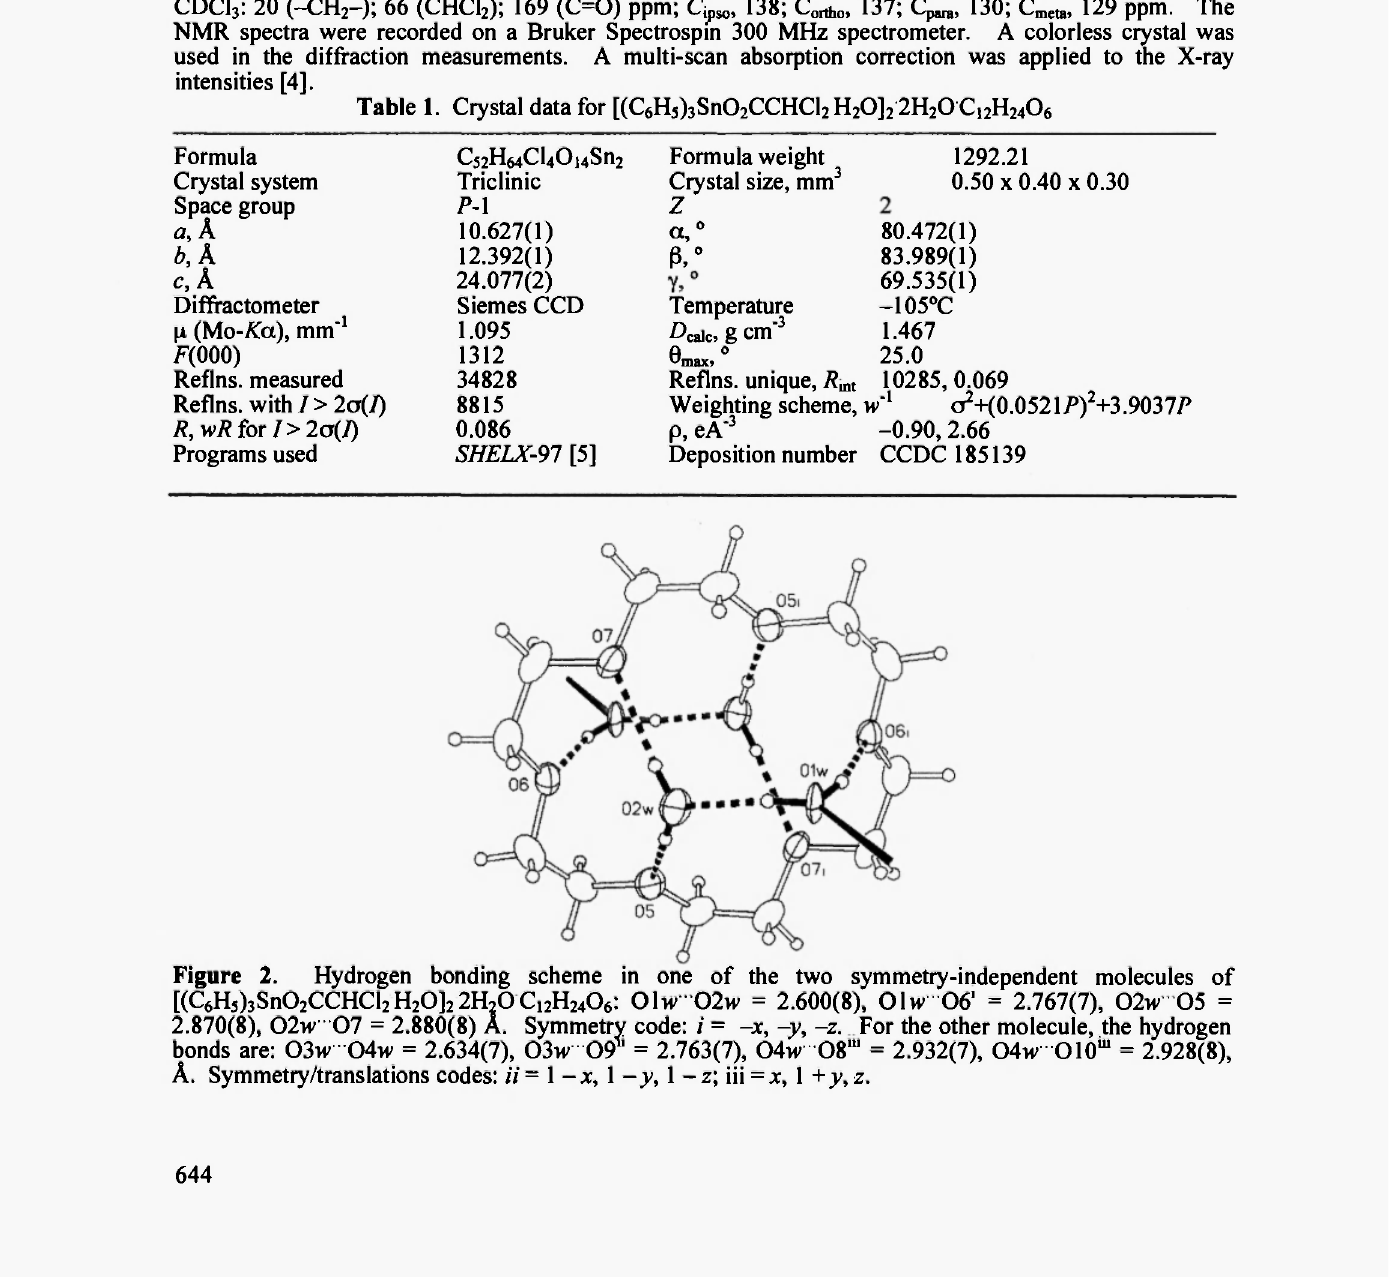
Table 1. Crystal data for [(C 6 H 5 ) 3 Sn0 2 CCHCl 2 H 2 0] 2